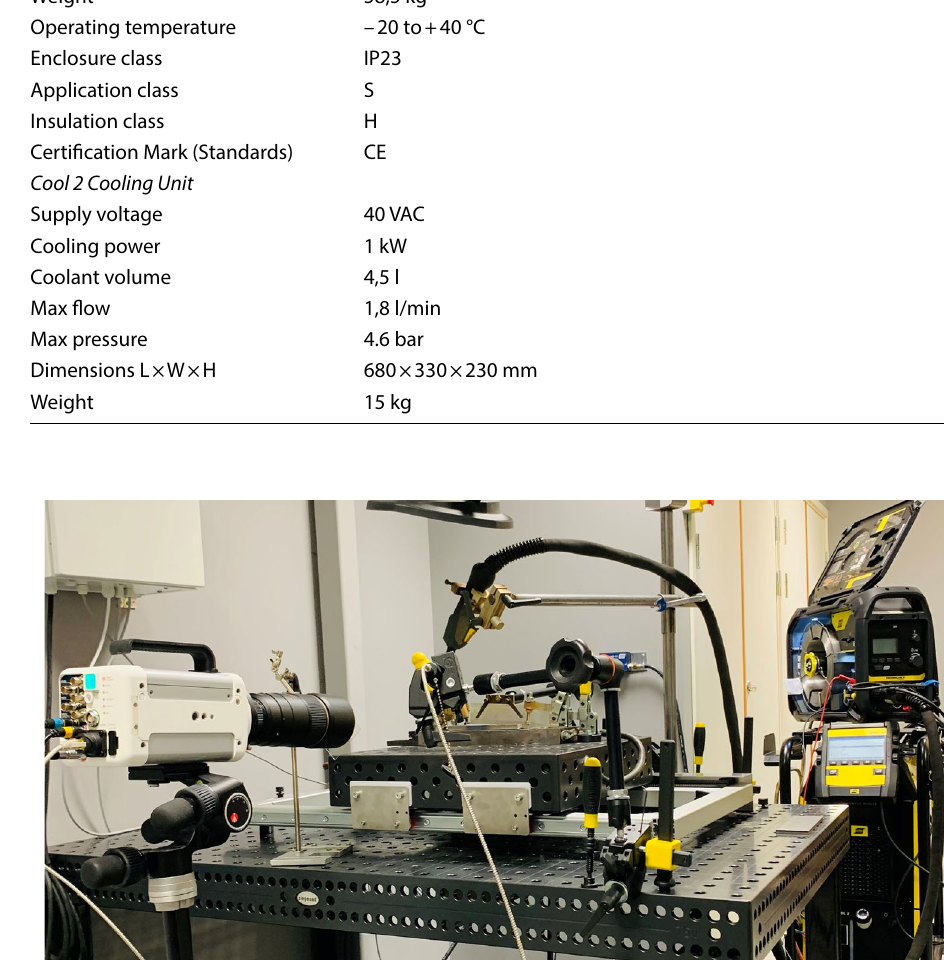
Figure 2. shows a picture of the image data and pro- cessing set used in performing the experiments. Show in this setup is the high-speed camera, power source,